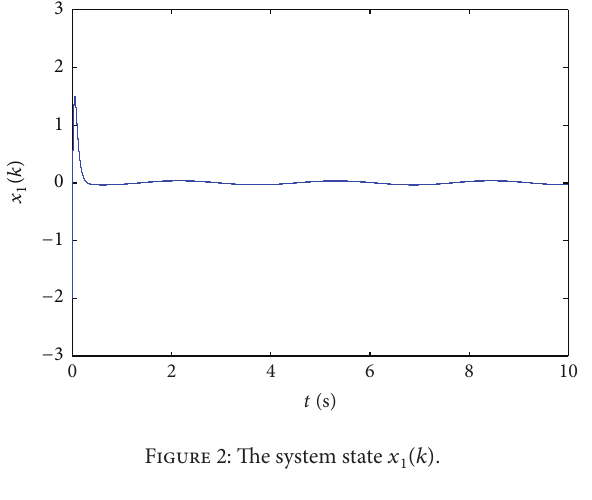
Figure 5: The disturbance 𝑑 1 (𝑘) and the estimation output of